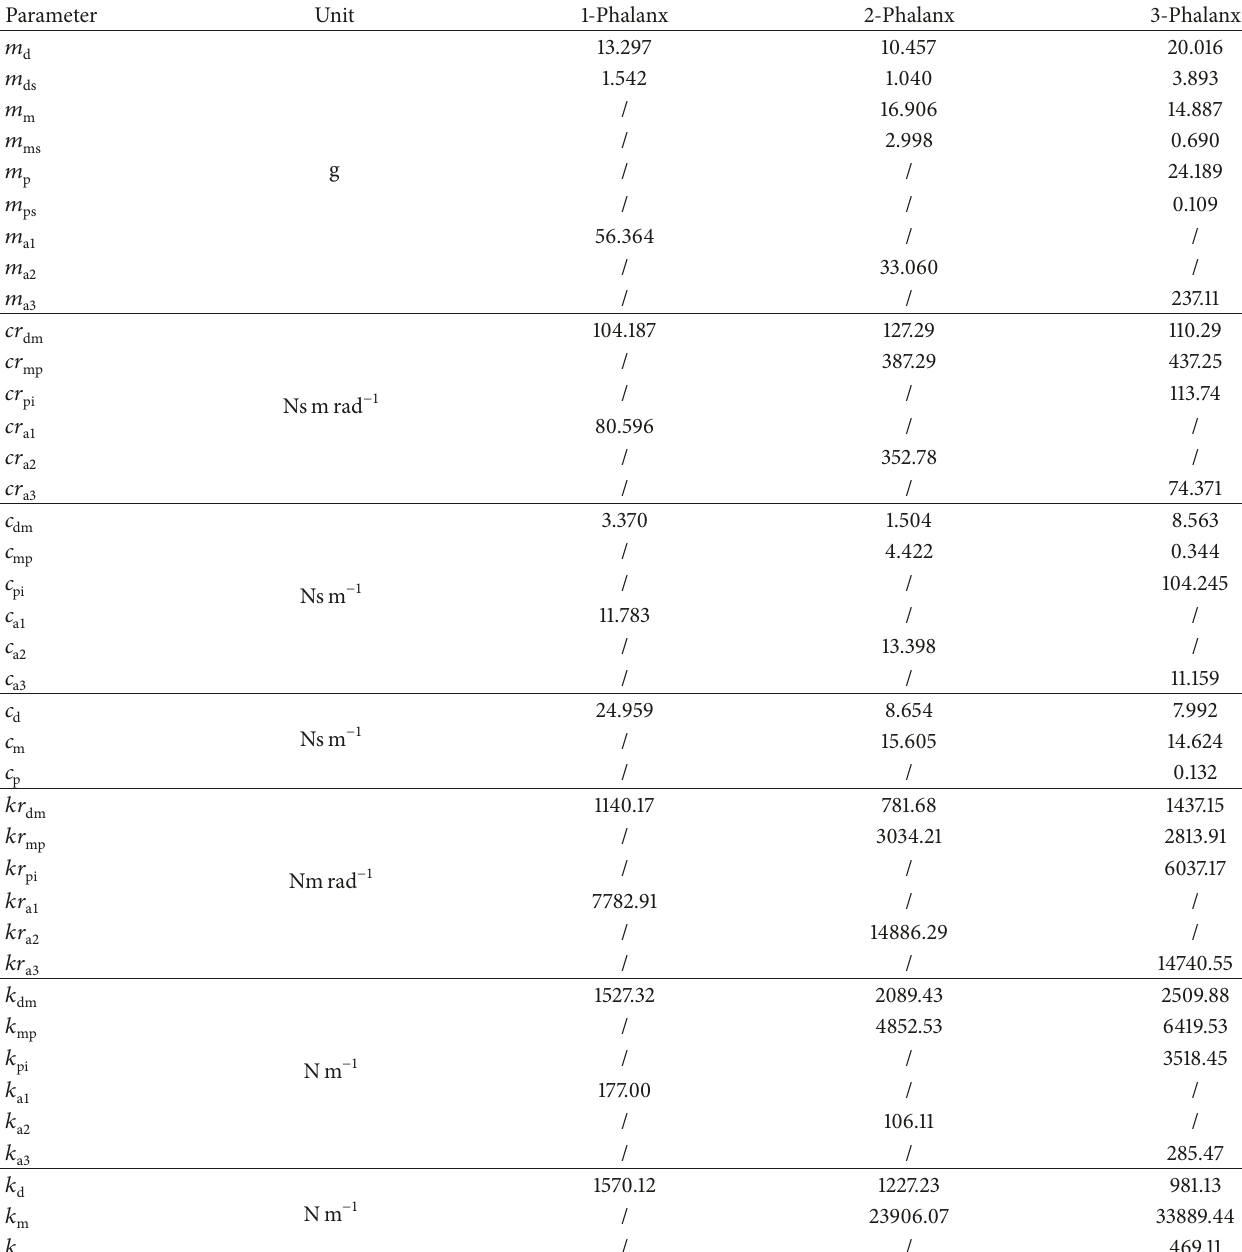
Table 2: Parameters of the biodynamic response-based models determined from the index-finger measurements using data fitting.